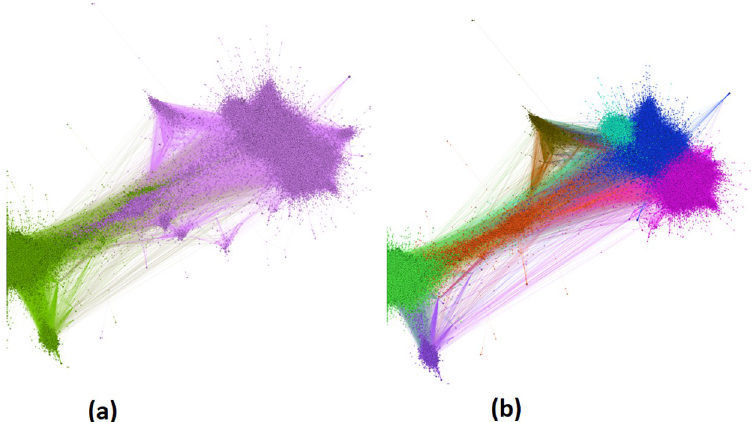
Fig 1. Retweet network of the election in Farsi twitter with different resolutions when calculating the modularity. The colors represent the node’s community that is detected by modularity. The size of the nodes is proportional to the accumulated number of retweets of the user. (a) resolution is set to 25 (b) resolution is set to 1.